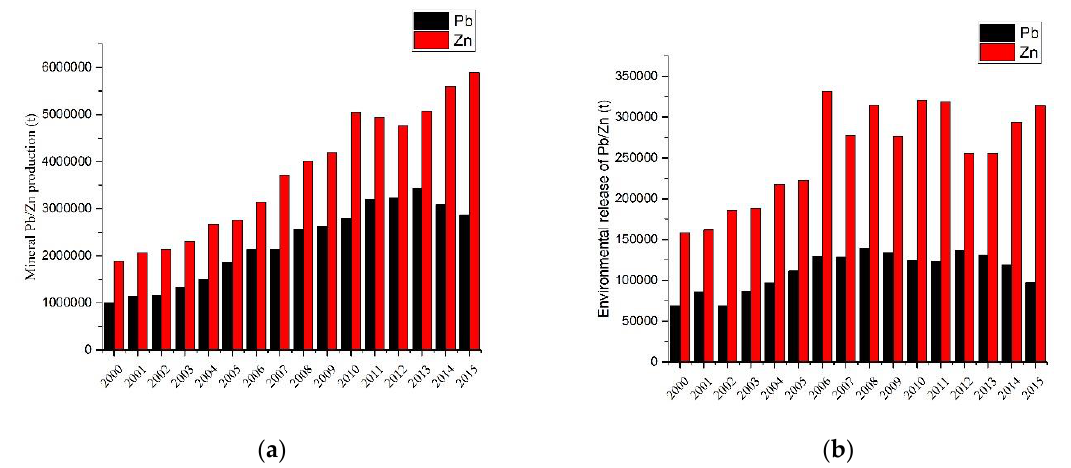
Figure 1. China’s mineral Pb/Zn production and environmental release from the period 2000 to 2015. ( a ) mineral Pb/Zn production; ( b ) environmental release of Pb/Zn.